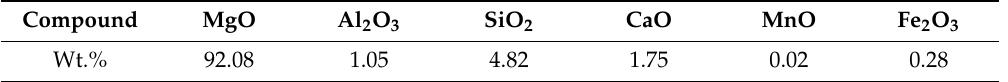
Figure 1. ( a ) SEM image of MgO particles; ( b ) SEM image of FD particles; ( c ) particle size distribution of MgO powder; ( d ) particle size distribution of FD powder. Table 2. The oxide composition of MgO powders measured by XRF. Table 2. The oxide composition of MgO powders measured by XRF.